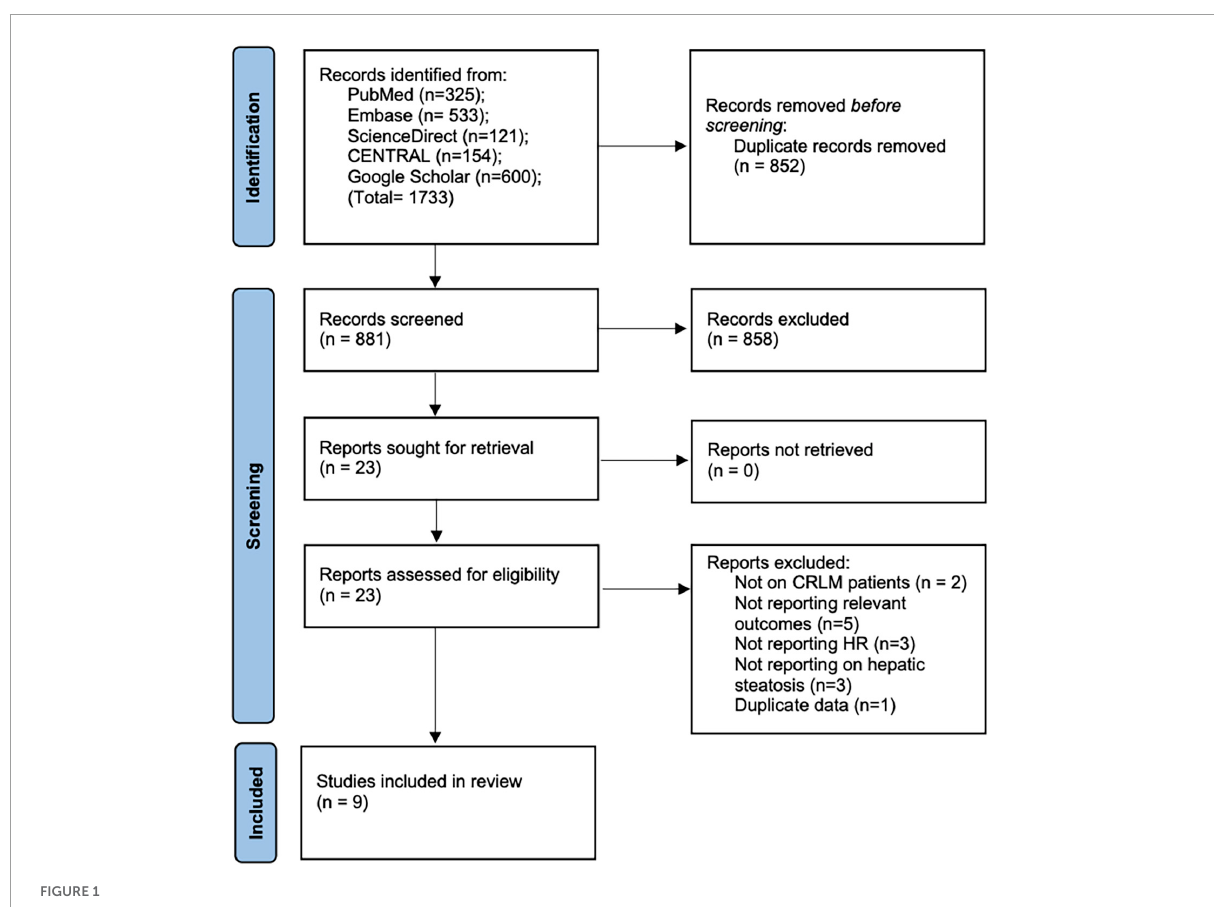
FIGURE1 Study flow chart.